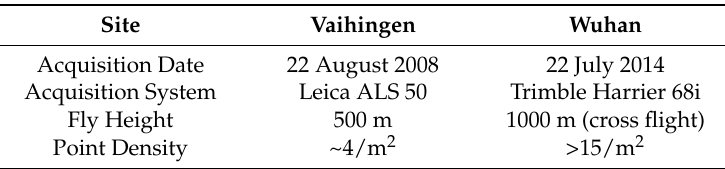
Table 1. Properties of the two datasets.